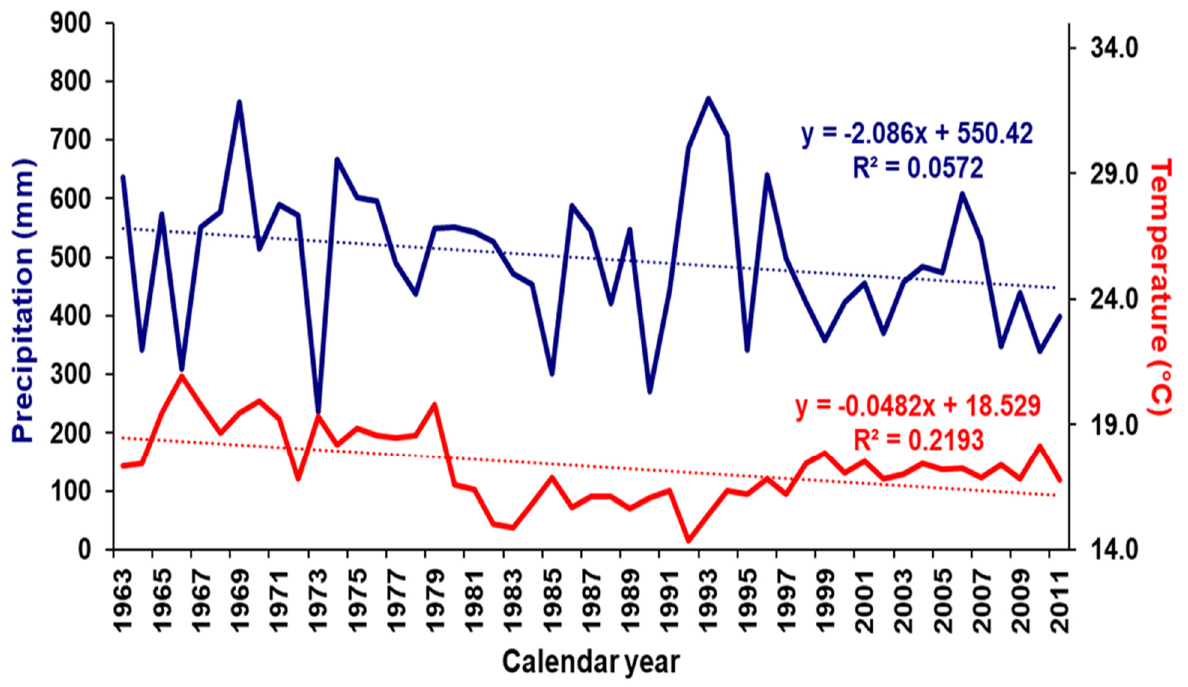
Figure 2. Total annual precipitation (blue line) and mean annual air temperature (red line) at Khorramabad meteorological station from 1963 to 2011. Dashed lines represent linear trends.